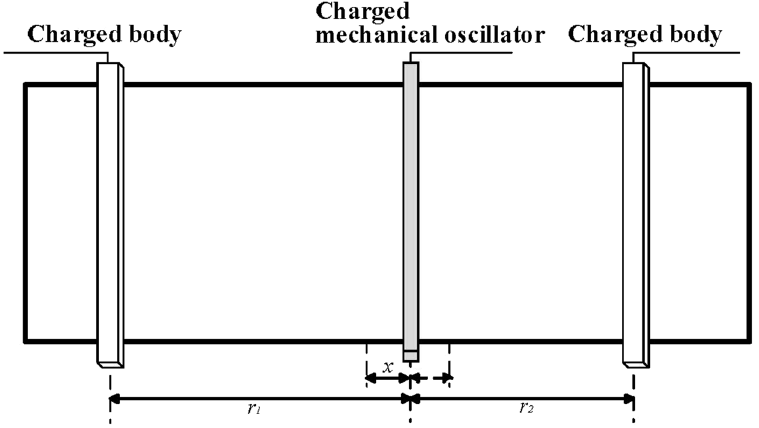
Figure 1. Schematic representation of the electromechanical system via the Coulomb